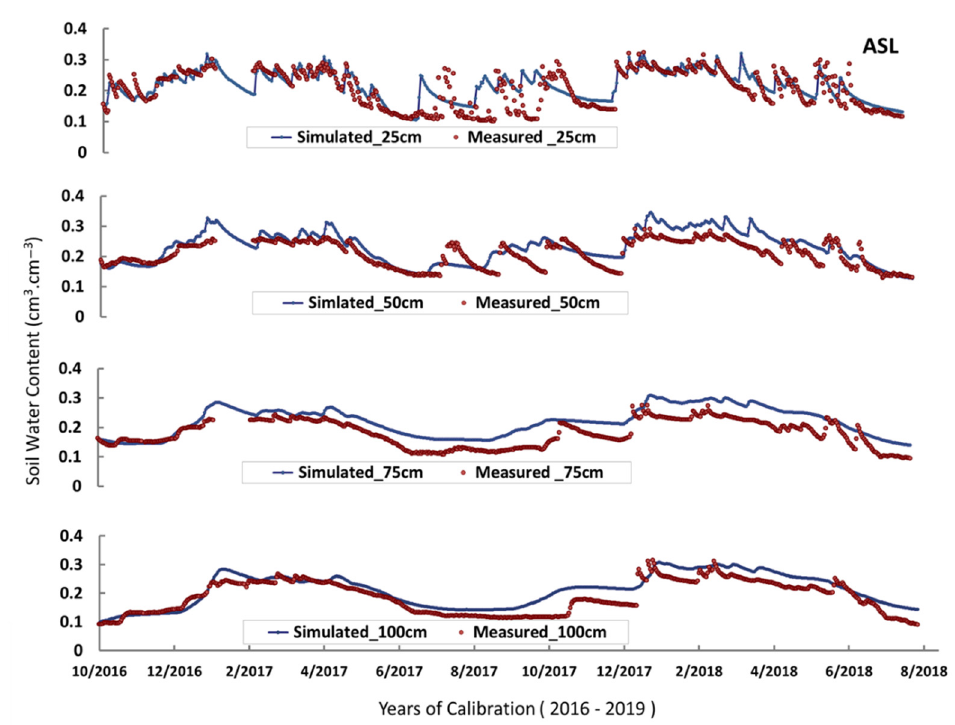
Figure 3. Measured (dots) and simulated (lines) soil water contents at four root zone depths of 25, 50, 75, and 100 cm at the ASL site.